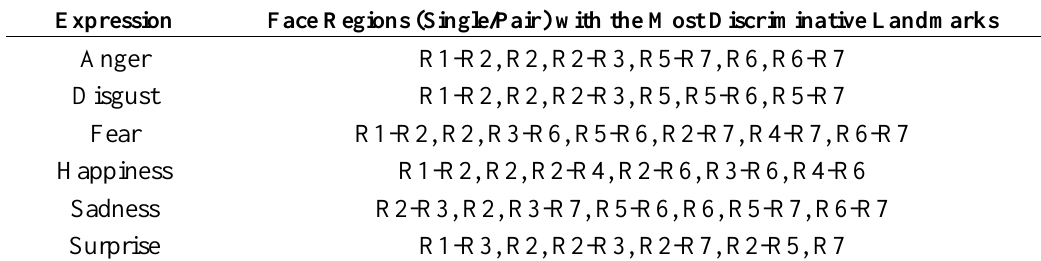
Table 1. Different regions (single/pair) of the face, with the most discriminative facial landmarks. Single region (Ri) means landmarks within this region are used to build a feature vector either from the stand alone landmark tracking result or pair of landmark tracking result. Pair of region (Ri–Rj) means two landmarks, one from each, is used to build the feature vector from the tracking result of those